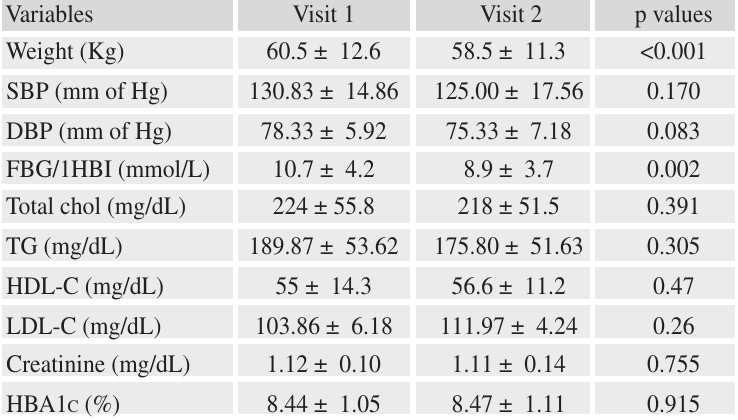
Table I: Comparison of anthropometric and laboratory values between visit 1 and visit